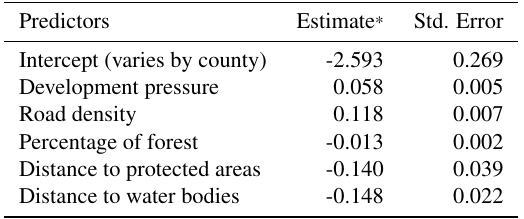
Table 1: List of selected predictors and estimated coefficients for site suitability model